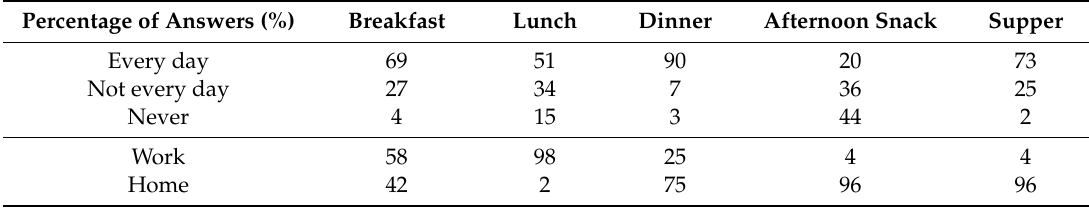
Table 1. Frequency and location of eating meals by soldiers